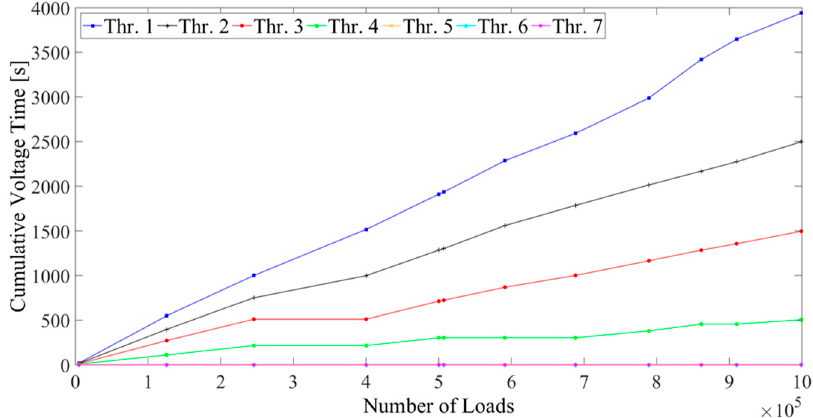
Figure 13. Cumulative voltage time for H7.